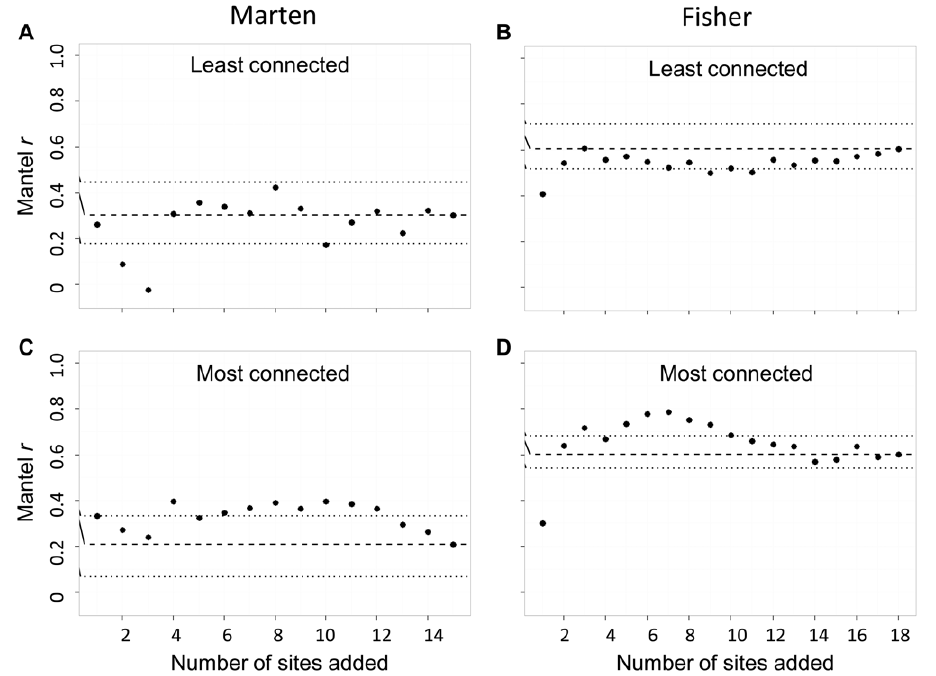
Figure 7. The effect of unsampled sites on Mantel r statistics testing isolation by distance. Each iteration represents the addition of one site to the network, such that sites are the least connected (panels a and b) or the most connected (panels c and d), for both the marten ( Martes americana ) and fisher ( M. pennanti ) datasets. The dashed line is the Mantel r (95% CI) statistic for the full dataset. Isolation by distance is the relationship between cGD and log Euclidean